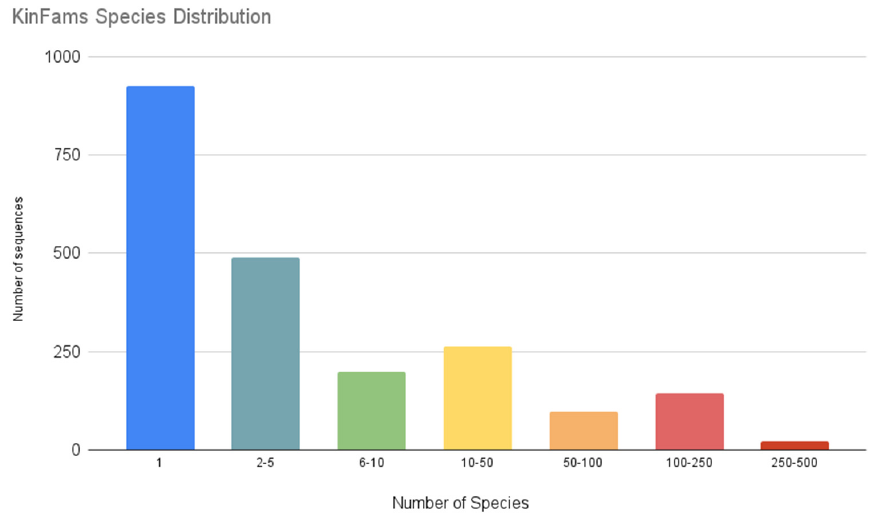
Figure 5. Species distribution associated with